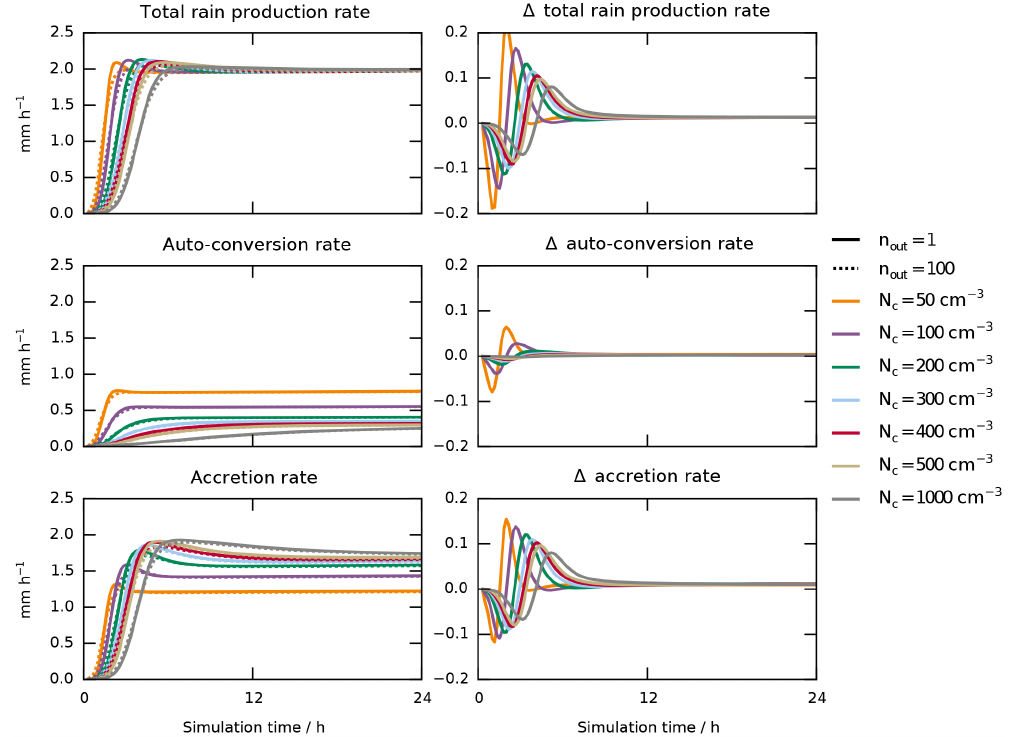
Figure 7. Rain production rates for the simulations described in the text. Solid lines are simulations with n out = 1, and dashed lines are simulations with n out = 100. Different colors represent simulations with different cloud droplet number concentrations reaching from 50 to 1000cm − 3 . The left column shows the total rain production rate and its constituents auto-conversion of cloud droplets to raindrops and accretion of cloud droplets by raindrops. The right column shows the differences ( R 1 − R 100 , for R n being any of the rates above) between the simulations with n out = 1 and n out = 100 for every